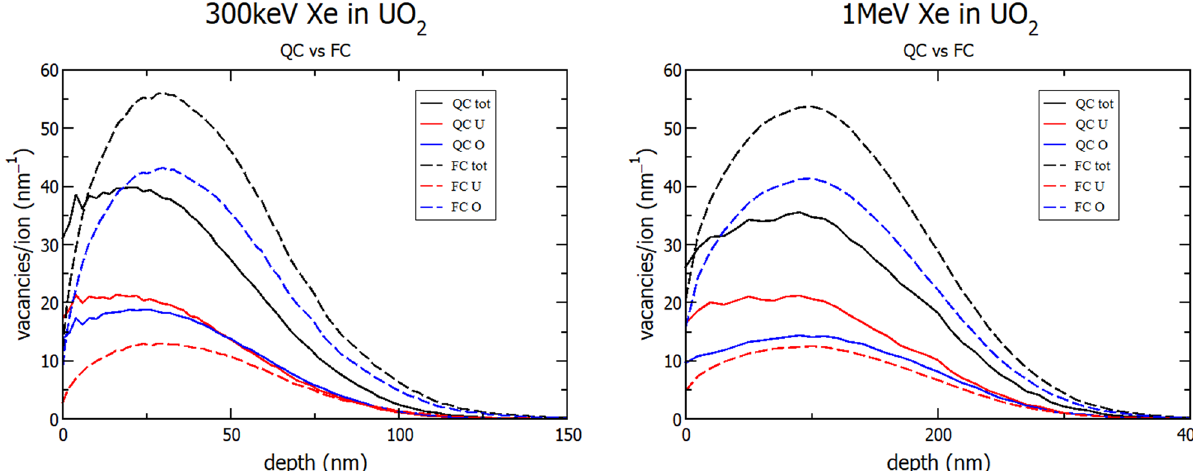
Fig. 5. Damage pro fi les for 300keV and 1 MeV Xe irradiation in UO 2 calculated with Iradina for quick calculation (solid lines) and full cascade (dashed lines). Black, red and blue curves are the total, uranium and oxygen vacancy production